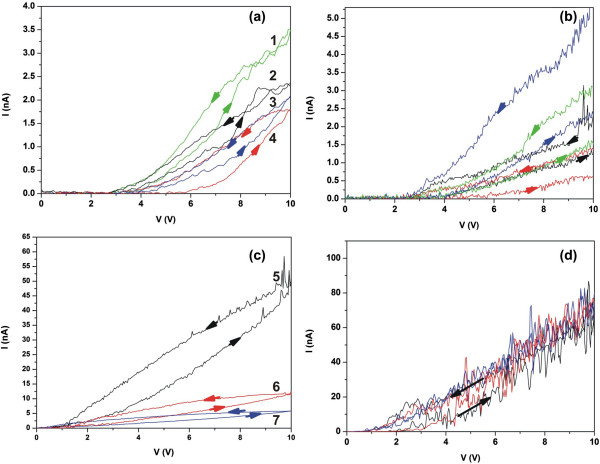
Double sweeping of voltage bias on different nanodomains of both a-TaNx films. (a) Positive and (b) negative voltage bias swept on four nanodomains (curves 1 to 4) of a-TaNx film deposited on Au. (c) Positive and (d) negative voltage bias swept on three nanodomains (curves 5 to 7) of a-TaNx film deposited on Si. In the first three figures, significant current hysteresis is observed, while in the last figure, hysteresis effects are negligible.